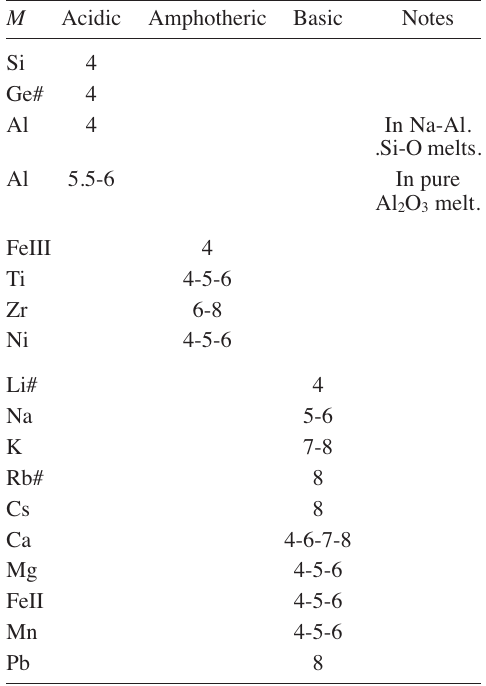
Table II. P = 1 bar mean M-O coordination number of cations in silicate melts and glasses. Listed figures are largely based on extensive compilation of Brown et al. (1995). Allocation among acidic, amphotheric and basic oxides after Ottonello and Moretti (2004) and this work